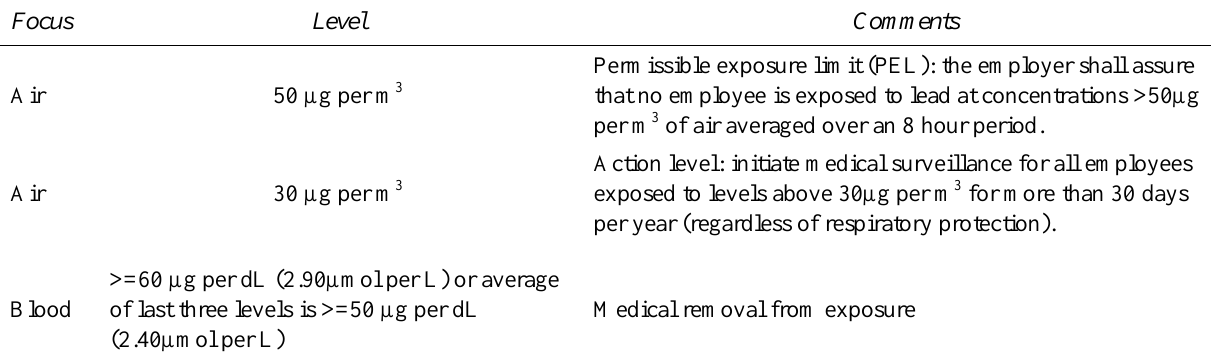
Permissible exposure limit (PEL): the employer shall assure that no employee is exposed to lead at concentrations >50µg per m 3 of air averaged over an 8 hour period. Action level: initiate medical surveillance for all employees exposed to levels above 30µg per m 3 for more than 30 days per year (regardless of respiratory protection).